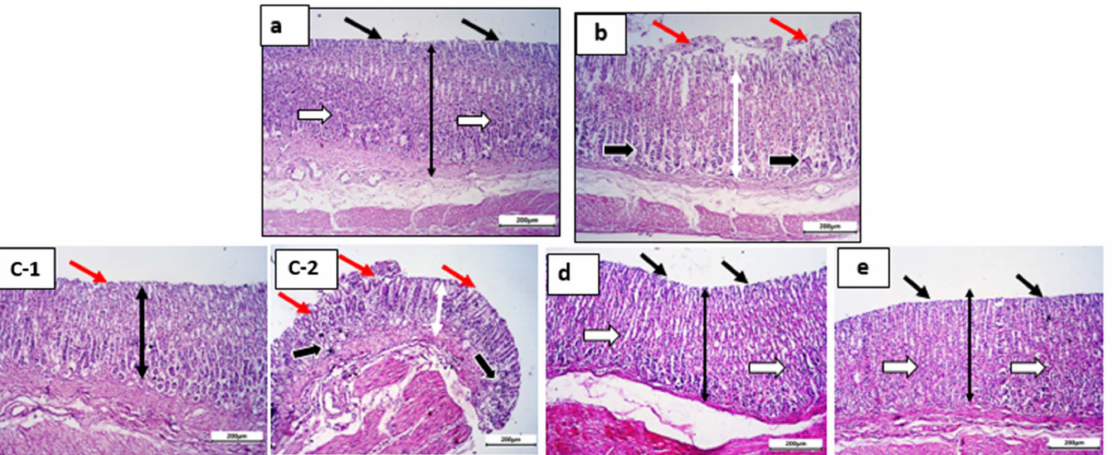
Figure 9. Histological sections from rat stomachs: ( a ) control group, ( b ) ketoprofen-treated group, ( c - 1 , c - 2 ) ketoprofen:tris Coppt, ( d ) ketoprofen:L-lysine Coppt, and ( e ) ketoprofen:arginine Coppt stained by H&E and photographed at low power x 100 (bar = 200 µ m) and x 400 (bar = 50 µ m).